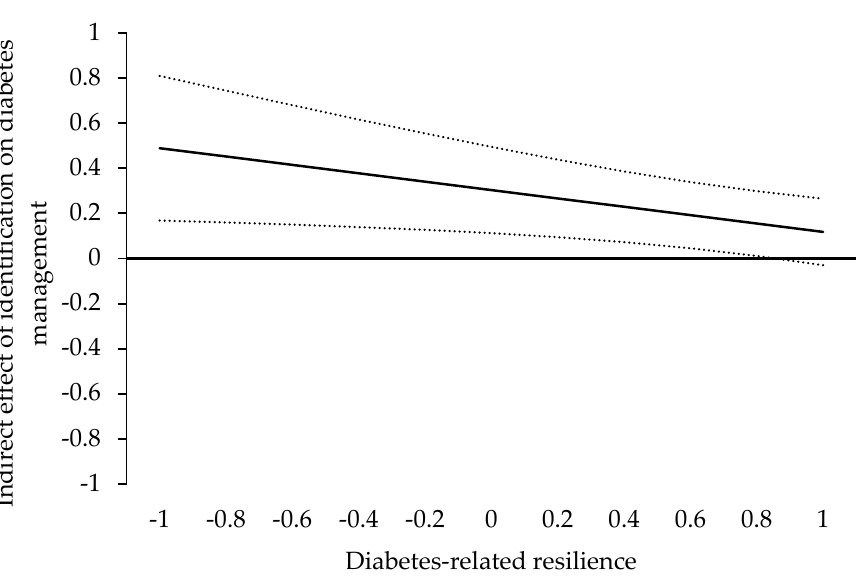
Figure 2. Visual presentation of the Johnson–Neyman Output for the indirect effect of identification with the medical practitioner on diabetes management. The y -axis depicts the indirect effect; the x -axis depicts the values for diabetes-specific resilience. The solid line represents the strength of the indirect effect; the dotted lines represent the lower and upper levels of the 95% confidence interval.